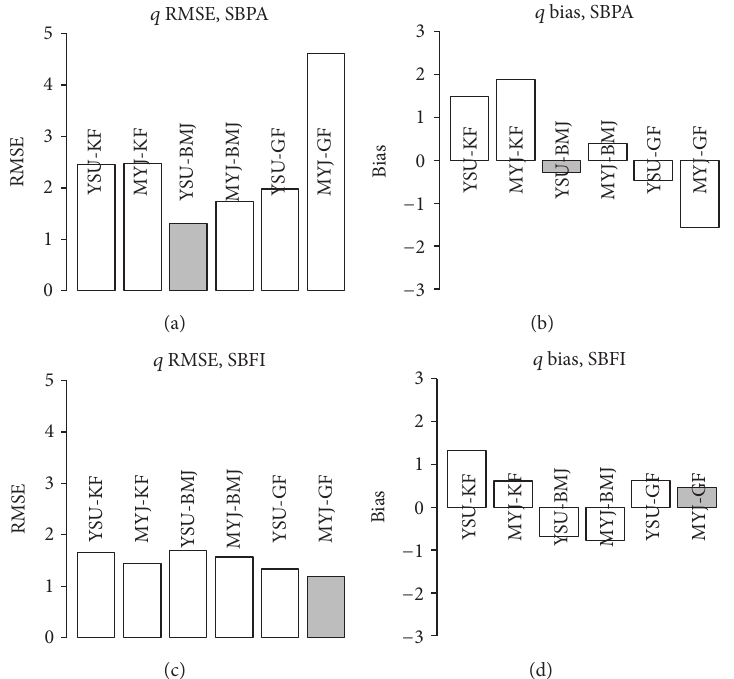
Figure 13: As in Figure 8 but for the simulated profiles of water vapor mixing ratio at SBPA [(a)-(b)] and SBFI [(c)-(d)] sites evaluated at 12Z 18 January